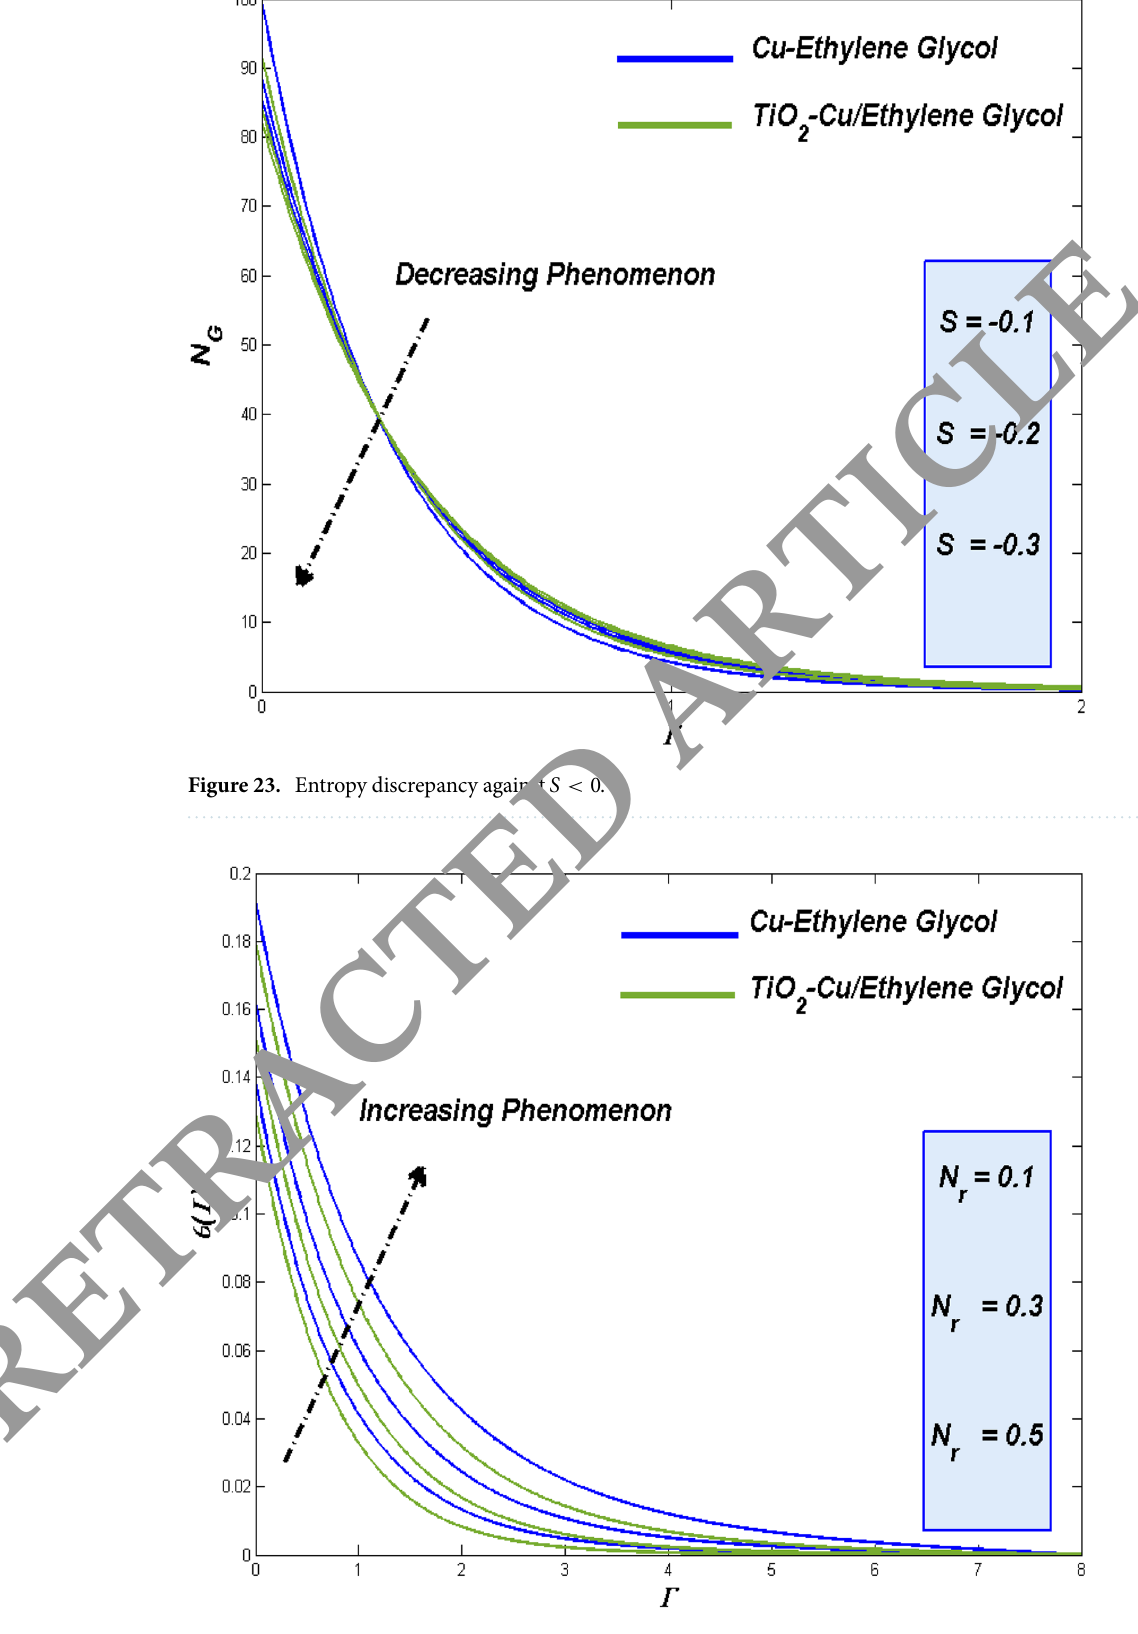
Figure 24. Temperature discrepancy against N r